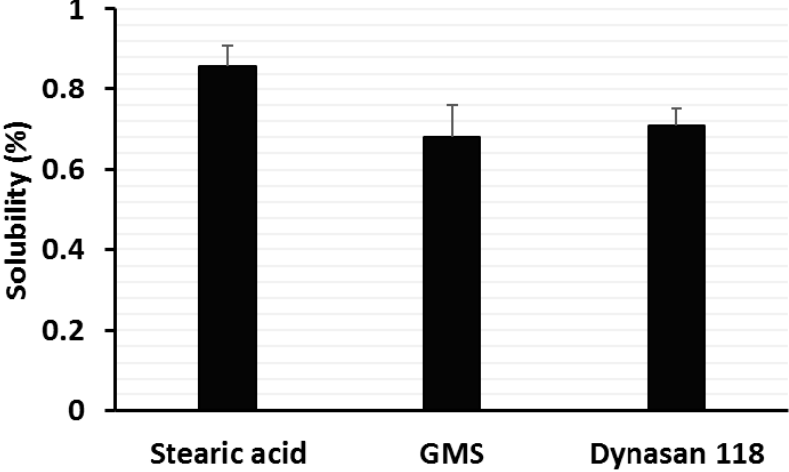
Figure 1. Solubility of wogonin in different solid lipids ( n = 3, mean ± SD). GMS, glycerol monostearate.